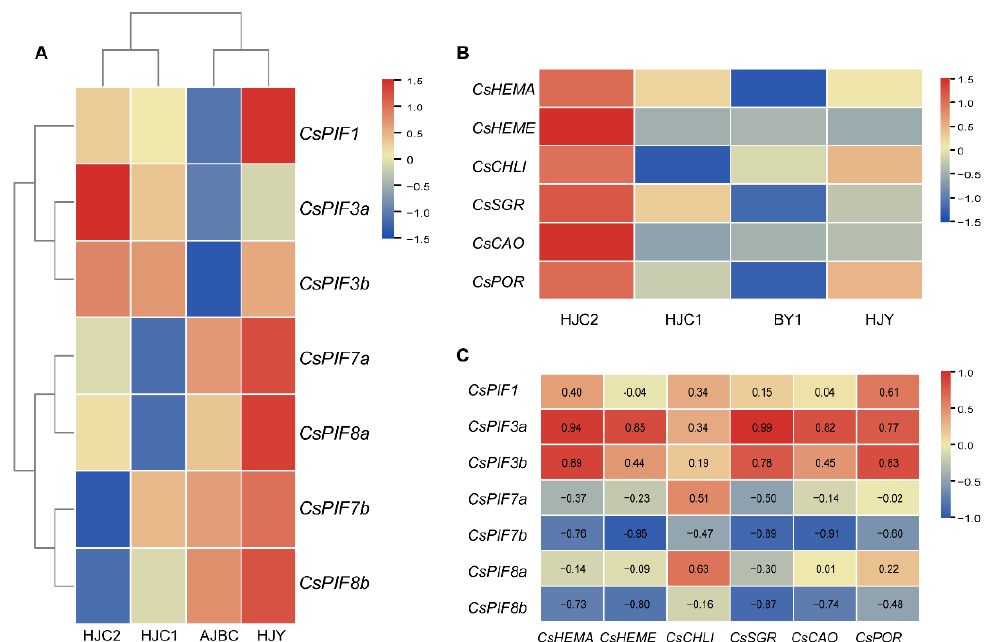
Figure 4. Expression patterns and correlation analysis of CsPIFs and structural genes related chlorophyll metabolism. ( A ) Expression patterns of CsPIFs in tea leaves of different leaf color tea cultivars. ( B ) Expression patterns of structural genes related chlorophyll metabolism in leaves of different leaf color tea cultivars. The red-blue schemes are labelled on the right side of heat map, and red to blue represent high to low expression levels. ( C ) Correlation between CsPIFs and structural genes related chlorophyll metabolism.